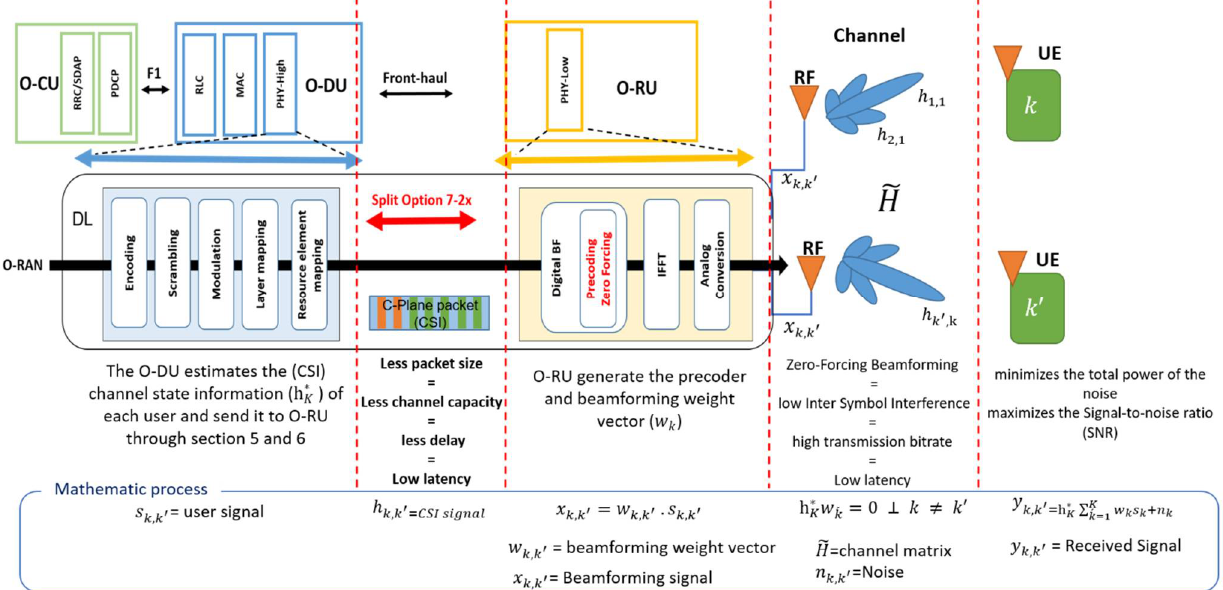
Figure 7. Implantation of digital beamforming with ZF precoder in O-RAN.